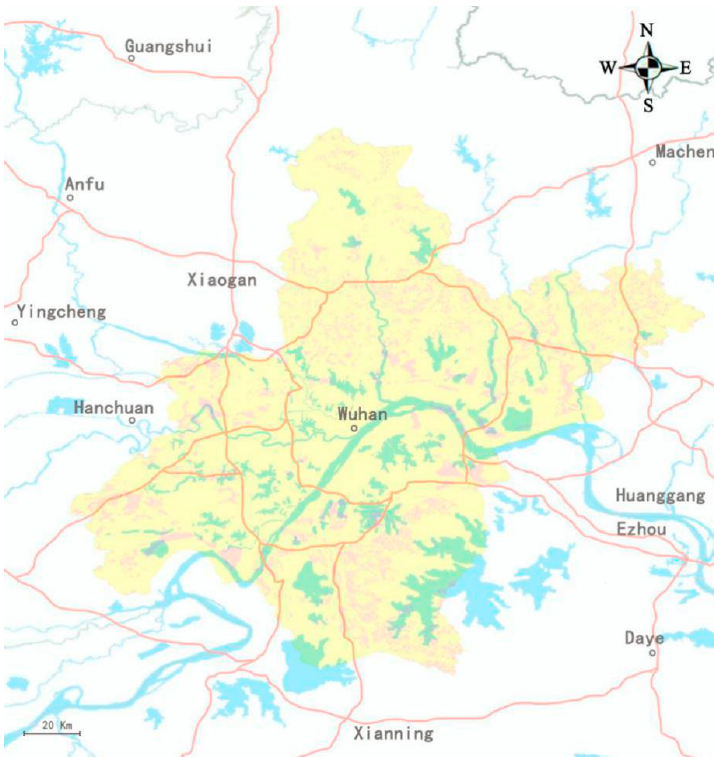
Figure 3. Screening medical waste disposal facility location areas based on ArcGIS software.